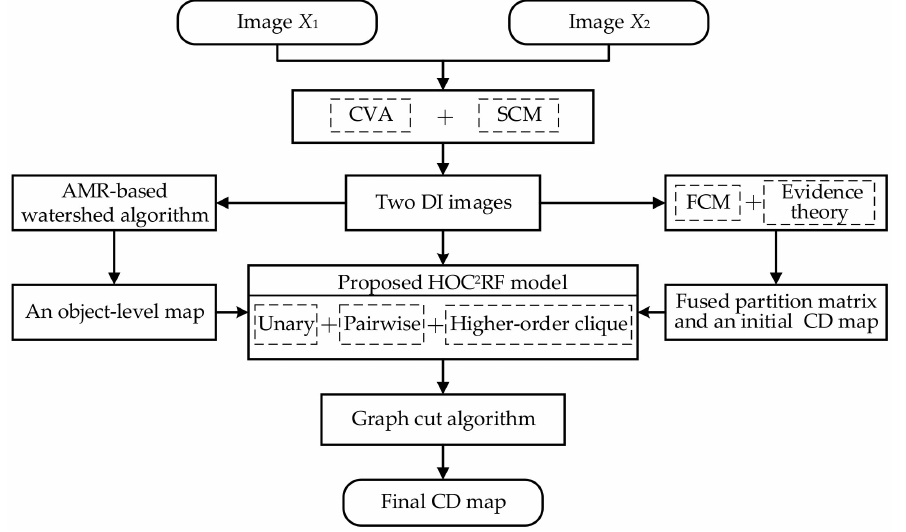
Figure 1. The flowchart of the proposed HOC 2 RF CD